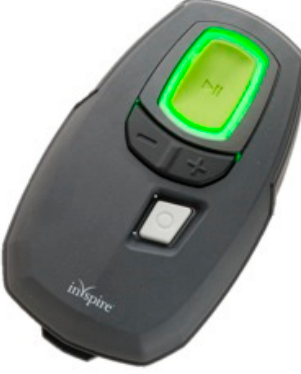
Figure 7. The Inspire remote.